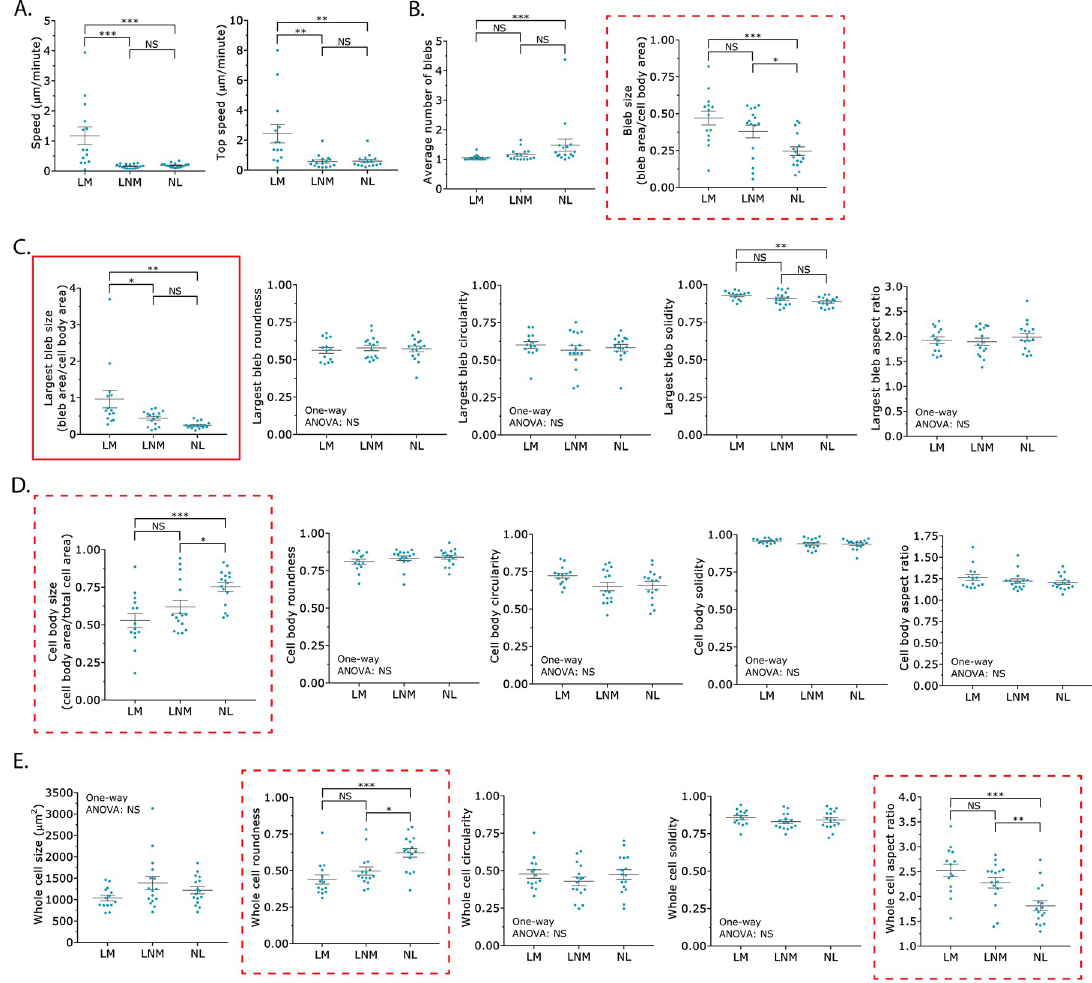
Fig 4. Shape descriptors may be used to characterize each phenotype. A. Instantaneous speeds ( left ) and top instantaneous speeds ( right ) for each phenotype. B. Average number of blebs ( left ) and bleb size ( right ) for each phenotype. C. Shape descriptors for the largest bleb across each phenotype. Solid red outline highlights the average largest bleb size as a shape descriptor that can differentiate between leader mobile (LM) from leader non-mobile (LNM) cells. D. Shape descriptors for the cell body across each phenotype. Dashed red outline highlights the average cell body size as a shape descriptor that can differentiate between leader non-mobile (LNM) from no leader (NL) cells. E. Shape descriptors for the whole cell across each phenotype. Dashed red outline highlights average whole cell roundness and average whole cell aspect ratio as shape descriptors that can differentiate between leader non-mobile (LNM) and no leader (NL) cells. Error is SEM. Statistical significance was determined using a One-way ANOVA and a Tukey’s post hoc test. All data are representative of at least three independent experiments. � —p � 0.05, �� —p � 0.01, ��� —p � 0.001, and ���� —p �